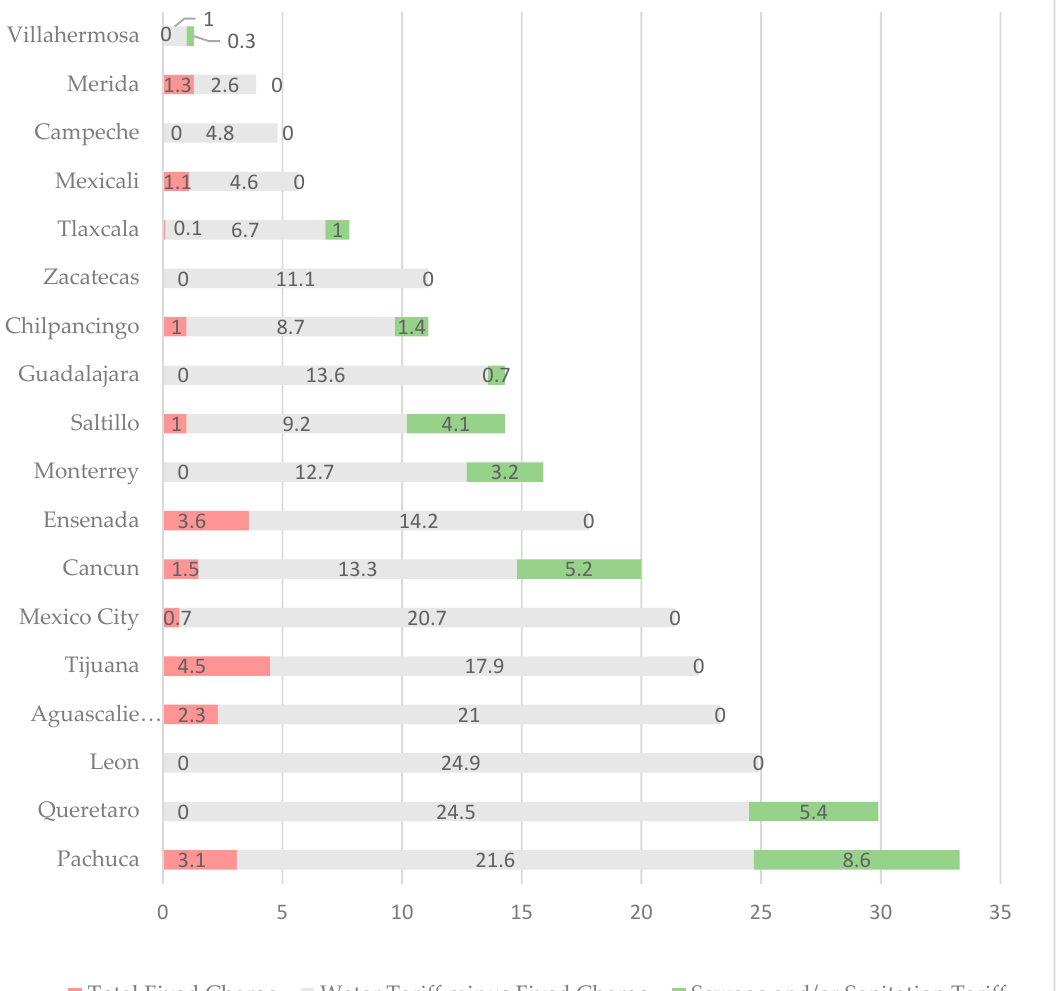
Figure 2. Drinking-water and sanitation tariffs for domestic use of residential type (or equivalent) in selected cities in Mexico, 2016 ($MX per cubic meter). Source: Authors’ elaboration with data from CONAGUA [23]; Note: Tariffs for a consumption of m 3 per month.